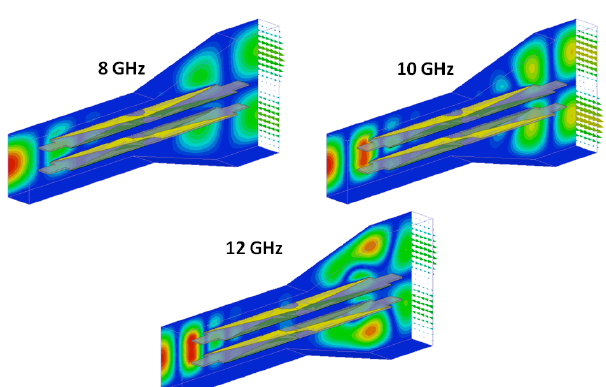
Figure 7: E-field distribution in the mode transformer at meanings frequencies.